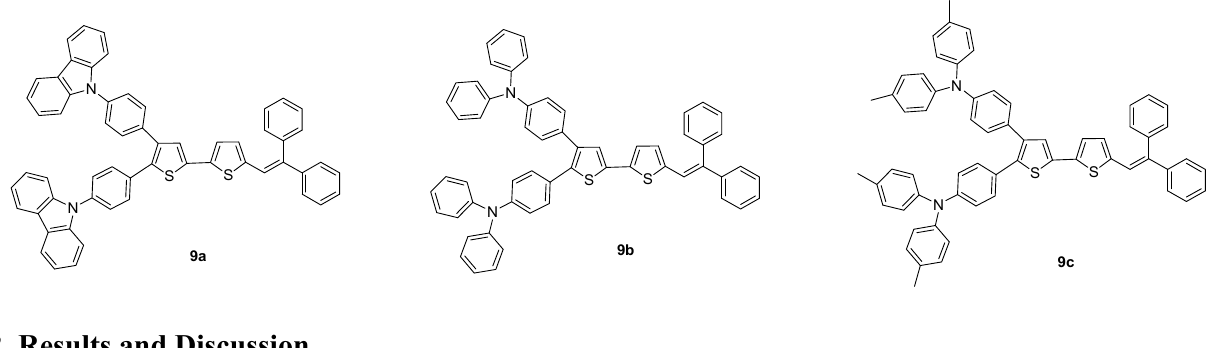
Figure 1. Structures of designed green dopants 9